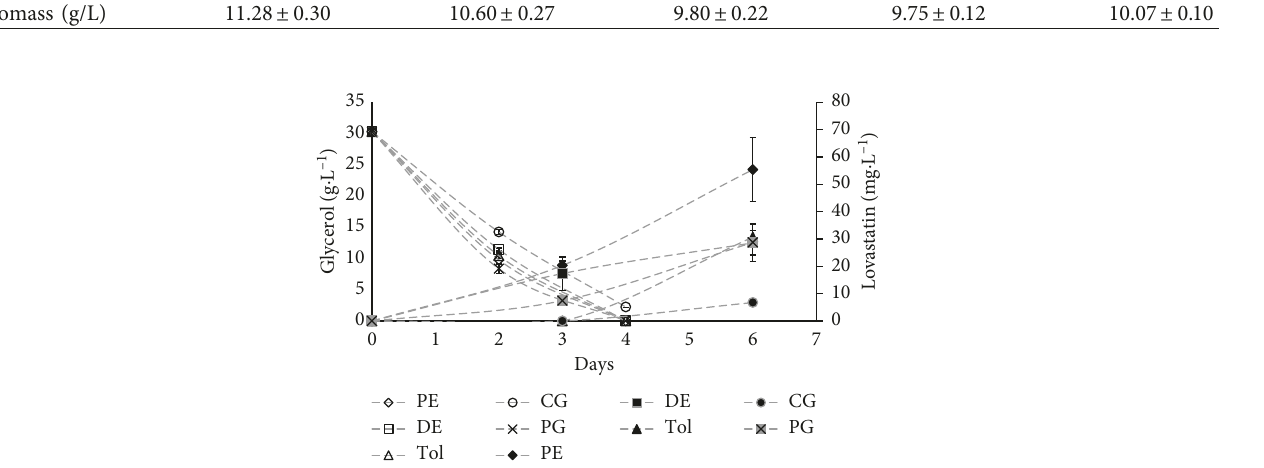
Table 1: The biomass production of A. terreus under different pretreatments of nonpolar solvents. The standard errors represent 95% confidence.